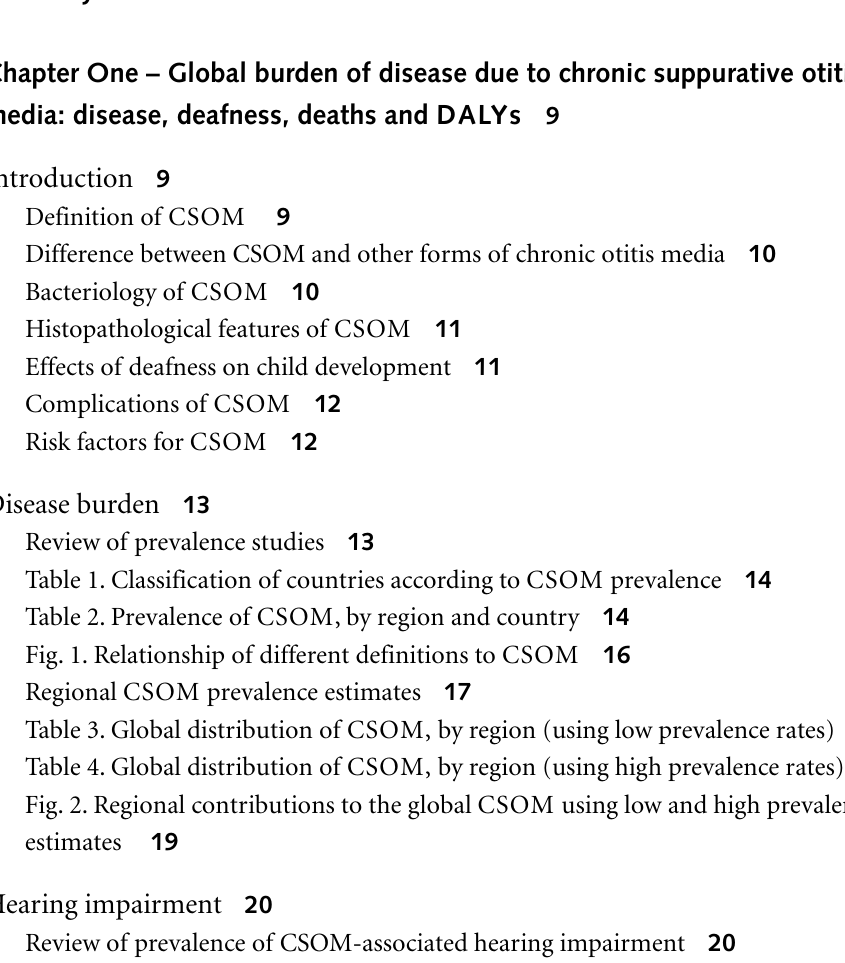
Table 5. Frequency of hearing impairment from CSOM in different study settings 20 Table 6. Regional burden of CSOM and hearing impairment from CSOM,